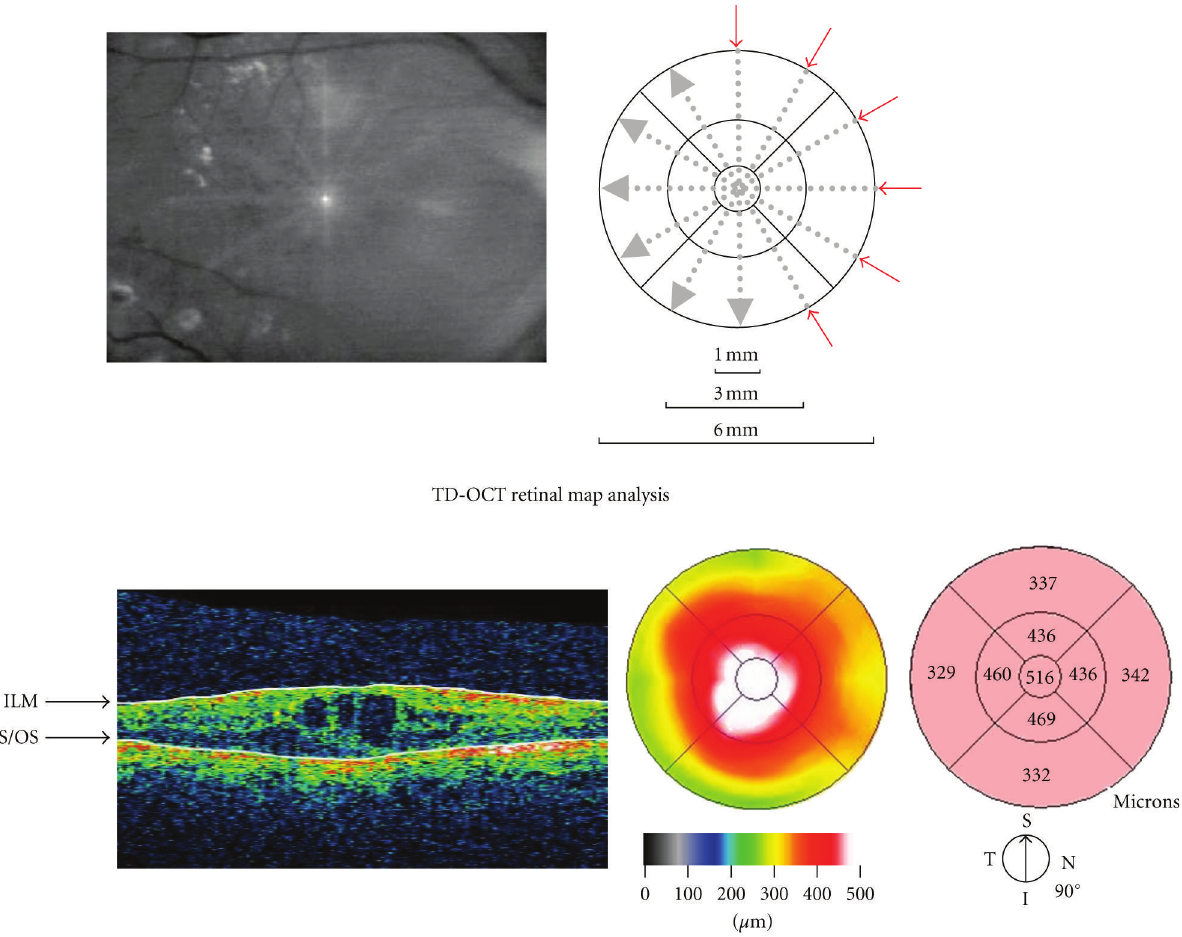
Figure 1: (Top) Fast macular thickness scan pattern with TD-OCT. (Bottom) The mean retinal thickness at the central 1mm circle is 516 µ m in a 74-year-old